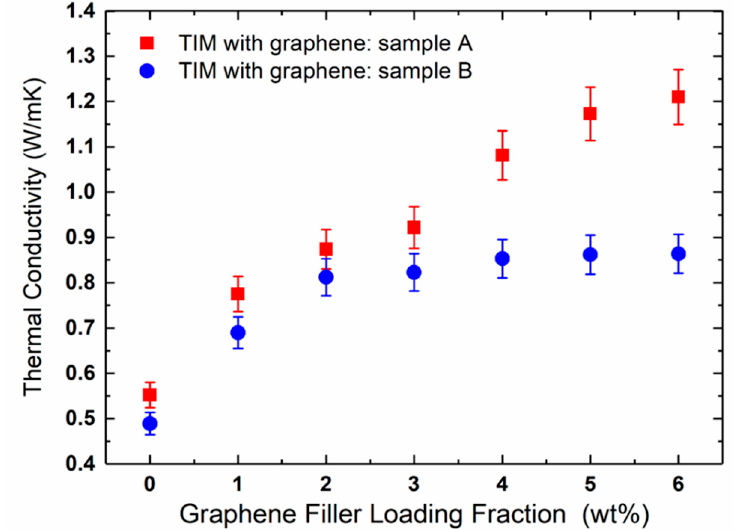
Figure 2. Measured apparent thermal conductivity of two representative commercial thermal interface materials, denoted as “sample A” and “sample B”, with added graphene fillers. The data are presented as a function of the graphene loading weight fraction. The measurements were conducted at T = 50 ◦ C and pressure of 100 kPa. Note that the apparent thermal conductivity values include the effects of the thermal contact resistance.